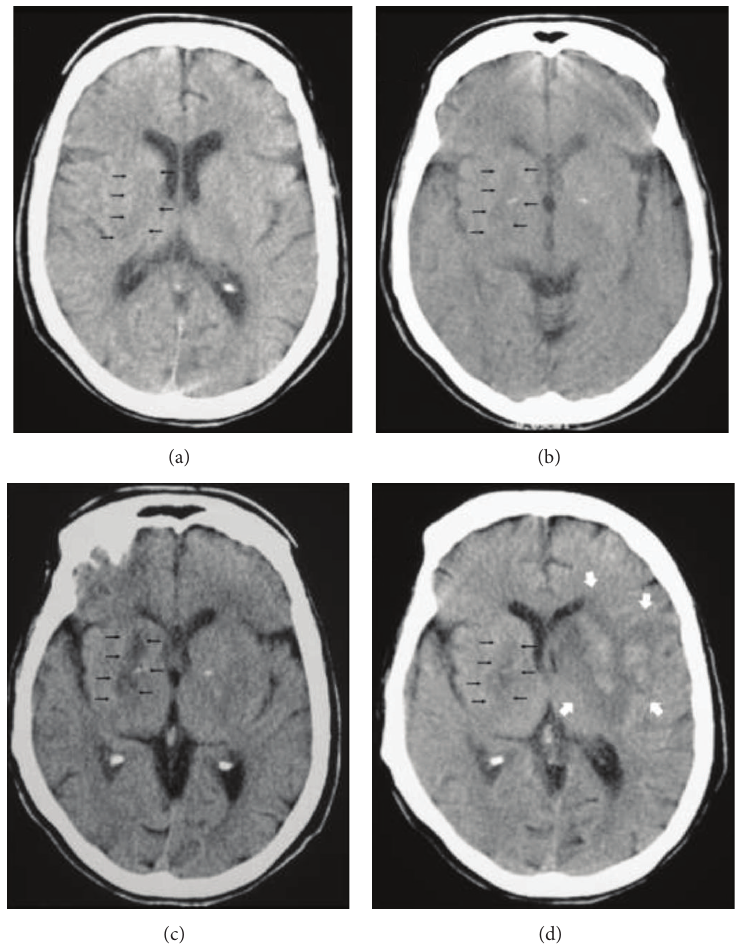
Figure 1: Cranial CT scan performed 100 minutes after first ischemic stroke onset (Panel a) and 24 hours after first IV thrombolysis (Panel b) shows a right lenticular hypodensity compatible with an acute cerebral infarction (black arrows). Cranial CT scan performed 30 minutes after second ischemic stroke onset (Panel c) and 48 hours after second systemic thrombolysis (Panel d) shows a subacute right lenticular infarction (black arrows) and a new predominantly subcortical ischemic lesion in the anterior region of the left middle cerebral artery territory with a PH2 hemorrhage (white